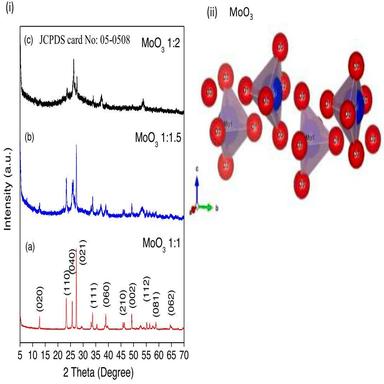
(i) XRD patterns of as-prepared MoO3 nanoparticles prepared at (a) 1:1, (b) 1:1.5 and (c) 1:2 of oxidiser to fuel ratio (ii) crystal structure of synthesized MoO3 nanoparticles.